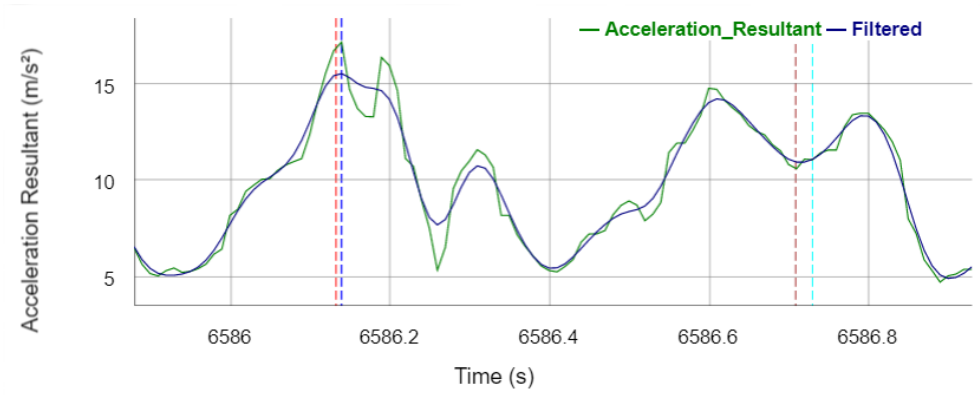
Figure 4. Acceleration resultant and the filtered signal during the stance phase with annotated reference gait events and events detected by the algorithm. Vertical dotted lines legend: red— reference IC Right ; brown—reference TO Right ; blue—sensor IC IMU ; turquoise—sensor TO IMU